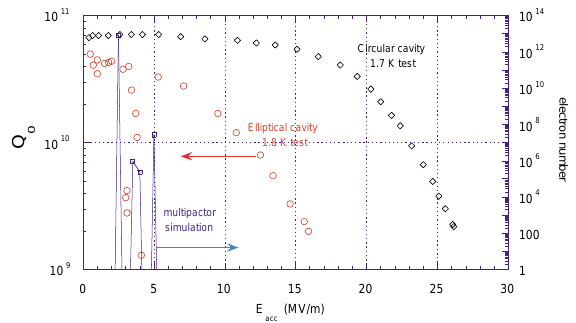
FIG. 1. (Color) Comparison between 700 MHz circular and el- liptical cavity cold test results and MP